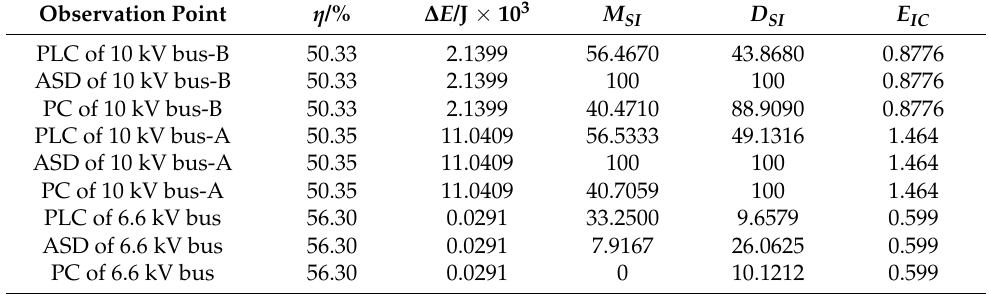
Table 6. Index value of